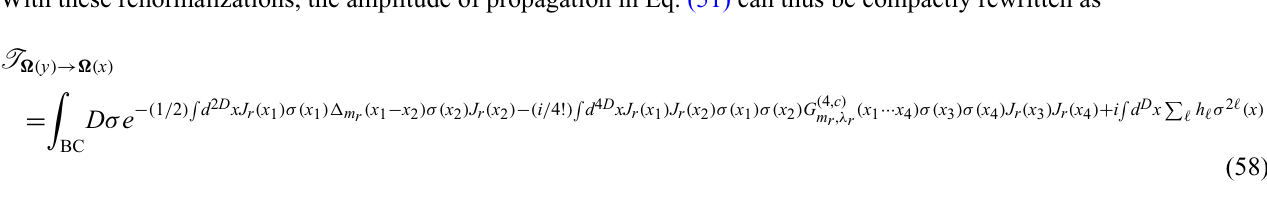
Finally, the interaction strength also gets renormalized due to the last diagram of Eq. (51), leading